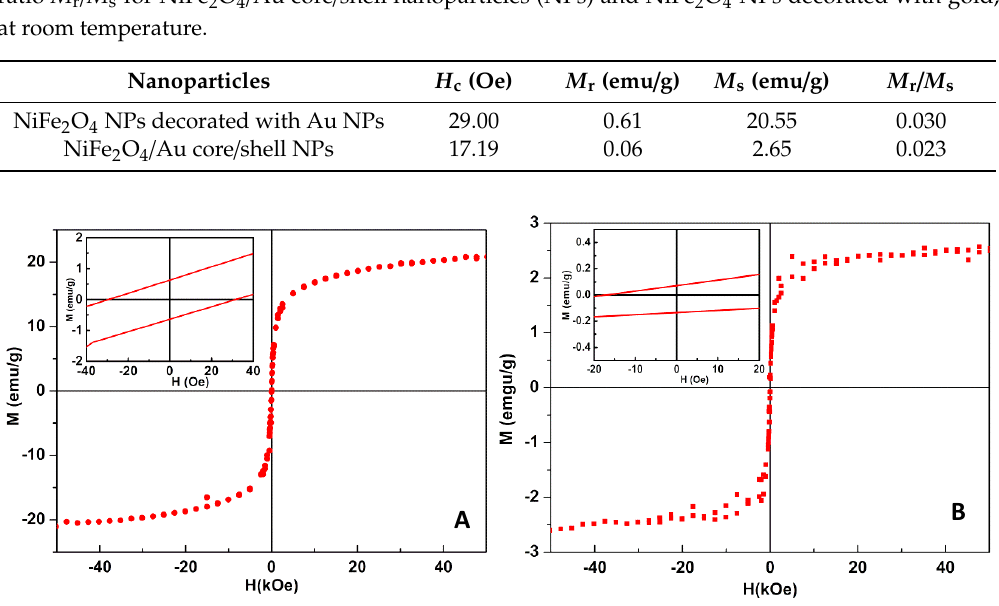
Figure 8. Magnetization hysteresis loops of magnetic / plasmonic nanoparticles at room temperature. ( A ) NiFe 2 O 4 nanoparticles decorated with Au nanoparticles. ( B ) NiFe 2 O 4 / Au core / shell nanoparticles. Insets: Enlargement of the loop in the low field region.